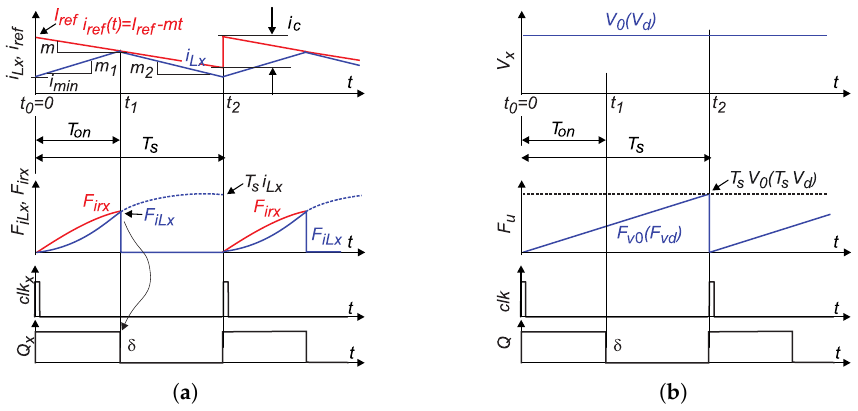
Figure 5. Current-Programmed Control Mode using VCOs; ( a ) current measurement, dynamic reference and triggering pulse generation; ( b ) voltage measurement.